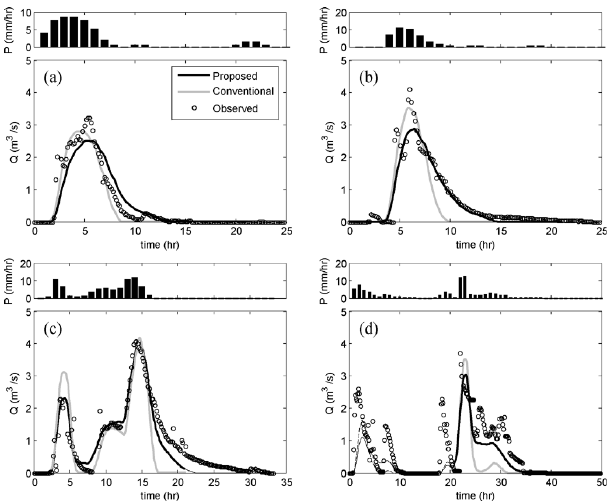
Fig. 6. Comparison of the conventional (considering Hortonian ex- cess runoff only) and proposed (considering both Hortonian excess runoff and infiltrated rainfall) approaches with the observed hydro- graphs for the storms in (a) April 2007, (b) August 2007, (c) Jan- uary 2008, and (d) April 2009.